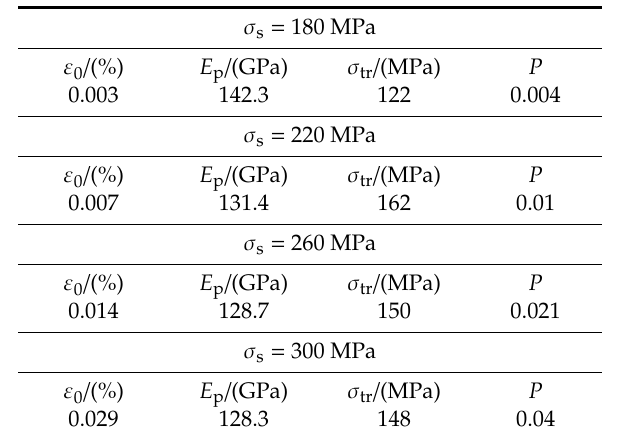
Table 10. The tensile stress–strain curve, tangent modulus, interface debonding fraction and broken fiber fraction of 2D SiC / SiC composite subjected to stochastic loading of σ s = 180, 220, 260 and 300